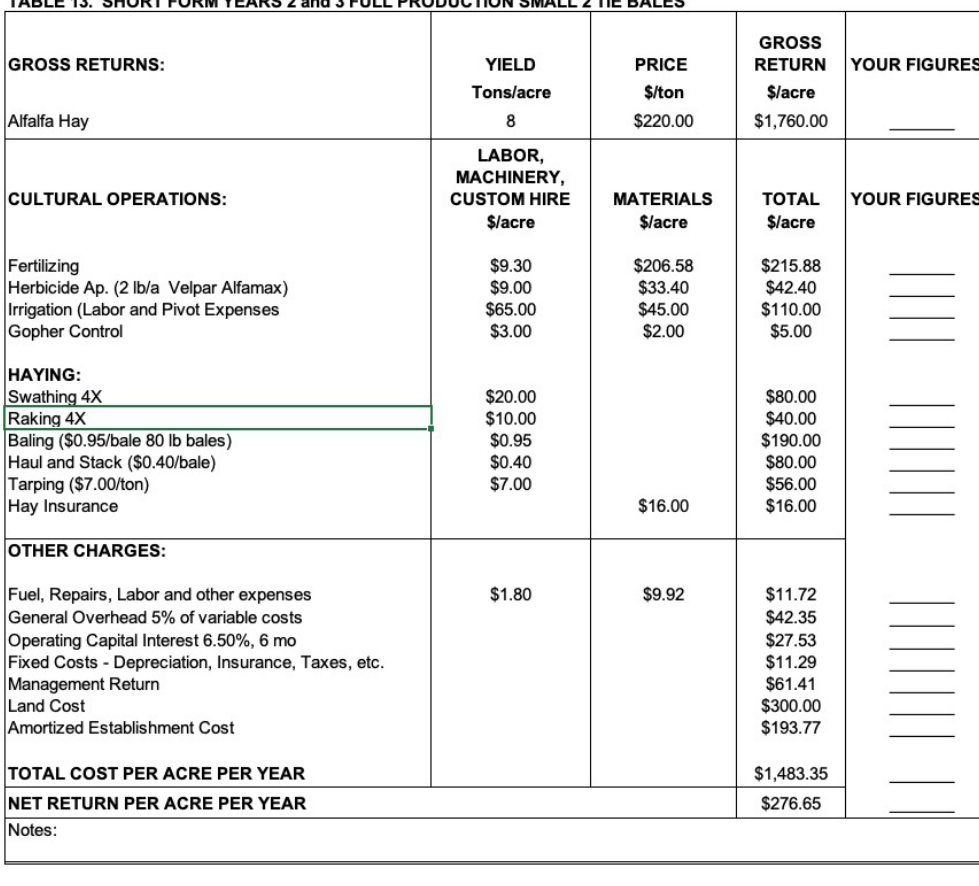
Figure 12. Alfalfa budget workbook guidelines developed by Washington State University Extension. Green bordered box indicates the currently selected cell while navigating the